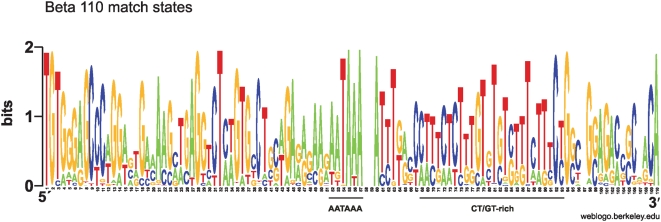
Weblogo for a Viterbi alignment of the beta training set (“beta” in Table 1).Insertions are not shown. The heights of the letters are a measure of how well conserved the residues are. Two bits correspond to 100% conservation.